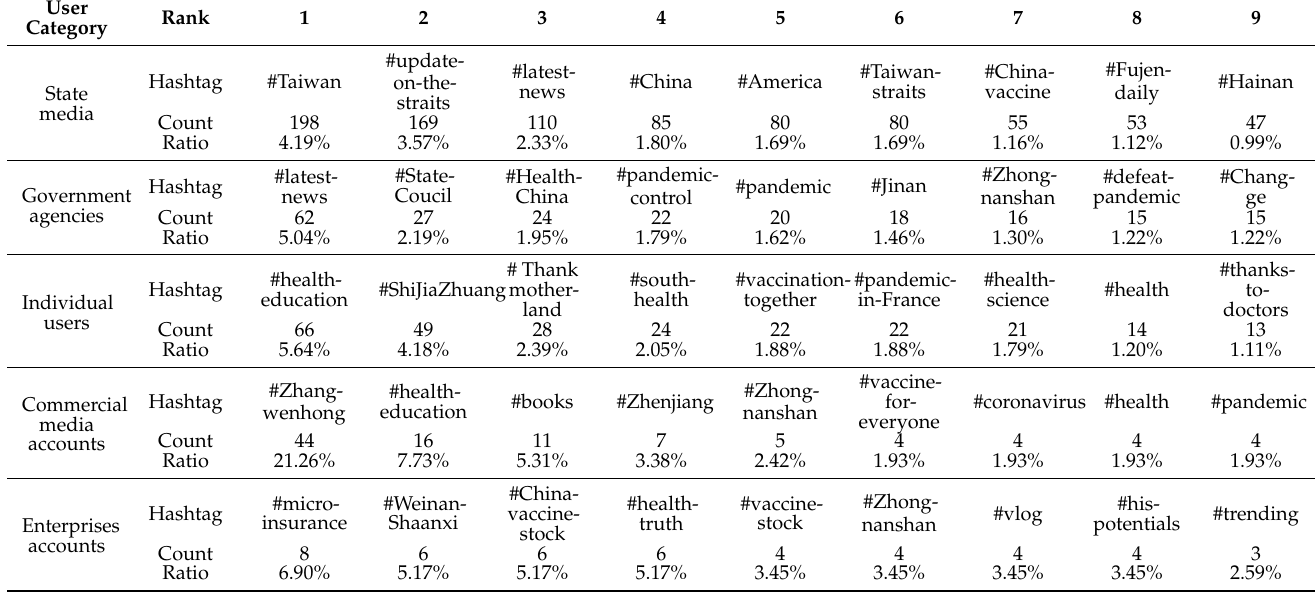
Table 2. Top hashtags used by different types of